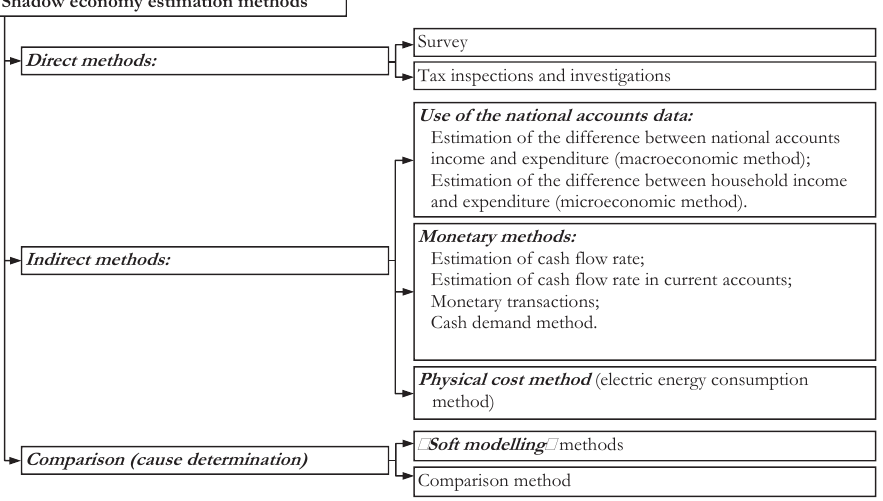
Fig. 1 – The structure of shadow economy estimation methods. Source: Genys